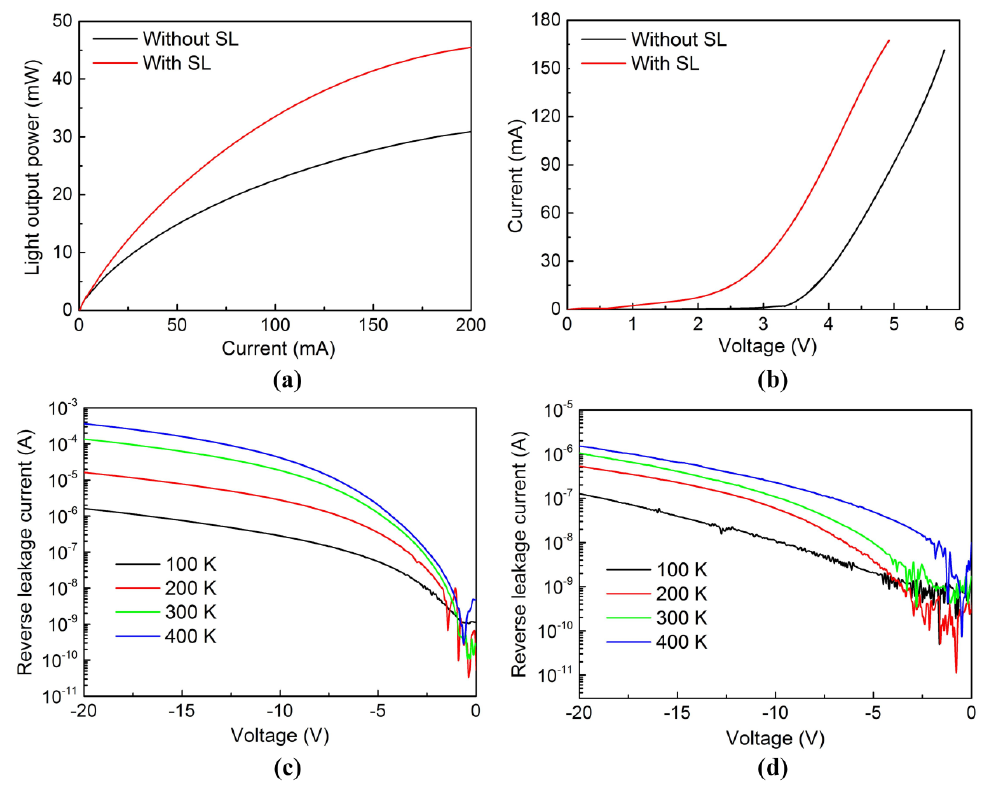
Figure 7. ( a ) Light output power versus current and ( b ) current versus voltage characteristics of green LEDs without and with an InGaN/GaN SL. Temperature-dependent current-voltage characteristics of green LEDs ( c ) without and ( d ) with an InGaN/GaN SL under the reverse bias condition.